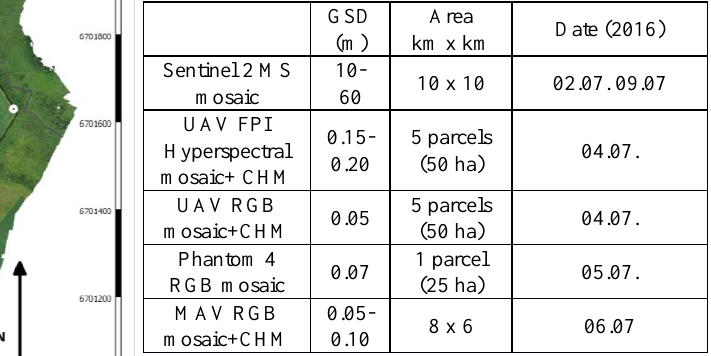
Table 1. Remote sensing materials used in the